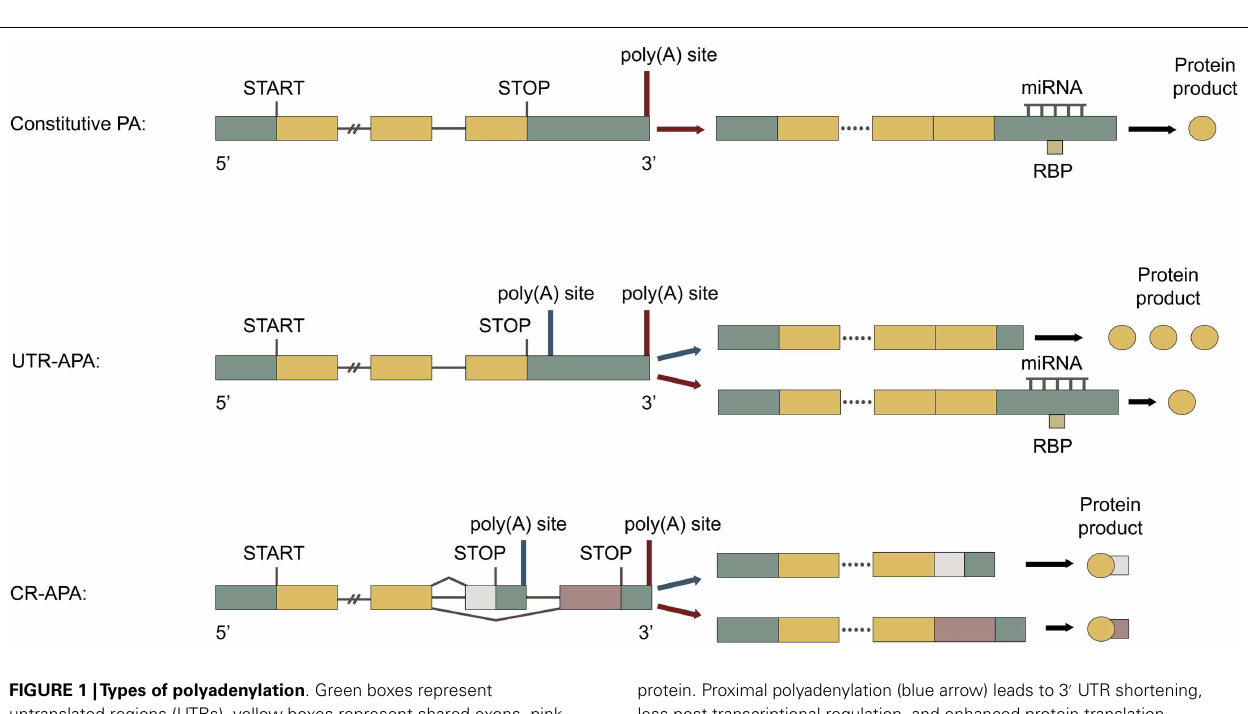
FIGURE 1 |Types of polyadenylation . Green boxes represent untranslated regions (UTRs), yellow boxes represent shared exons, pink, and white boxes represent unshared exons and the connecting horizontal lines represent introns. Adapted from Di Giammartino et al. (2011).Top: constitutive polyadenylation: gene contains only one poly(A) site and can therefore not undergo APA. Middle: untranslated region (UTR)-APA: gene contains multiple poly(A) sites located in the 3 (cid:48) UTR of the terminal exon. APA results in mRNAs with different lengths of 3 (cid:48) UTR, producing the same